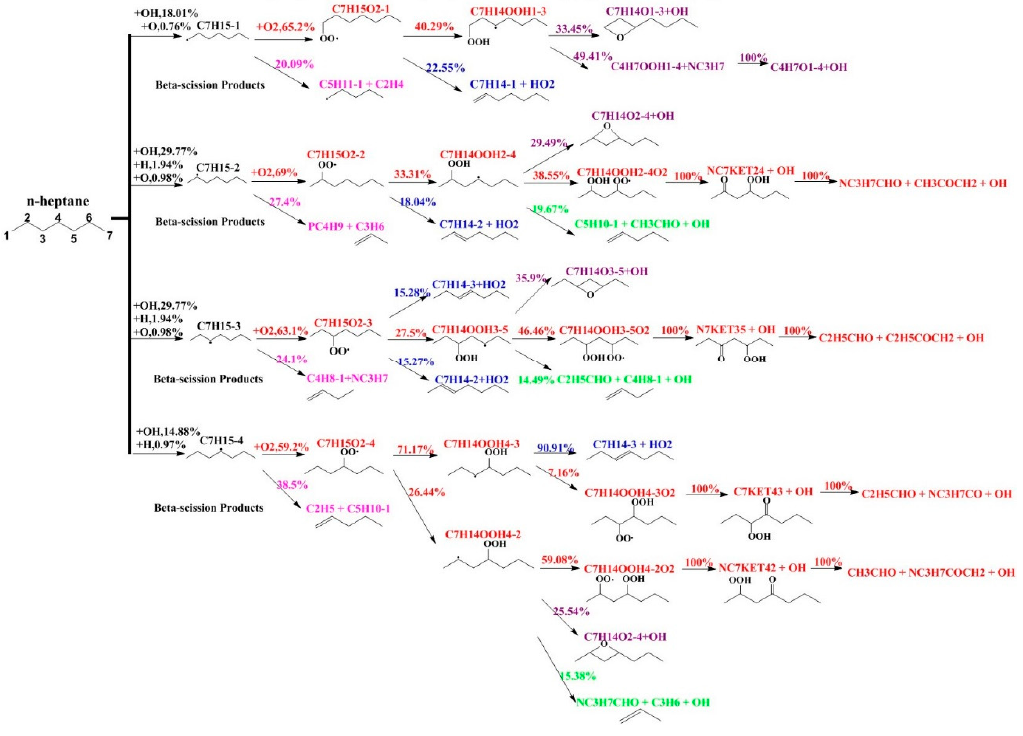
Figure 14. Heptane reaction path analysis (900 K, 4000 kPa, equivalent ratio 1).